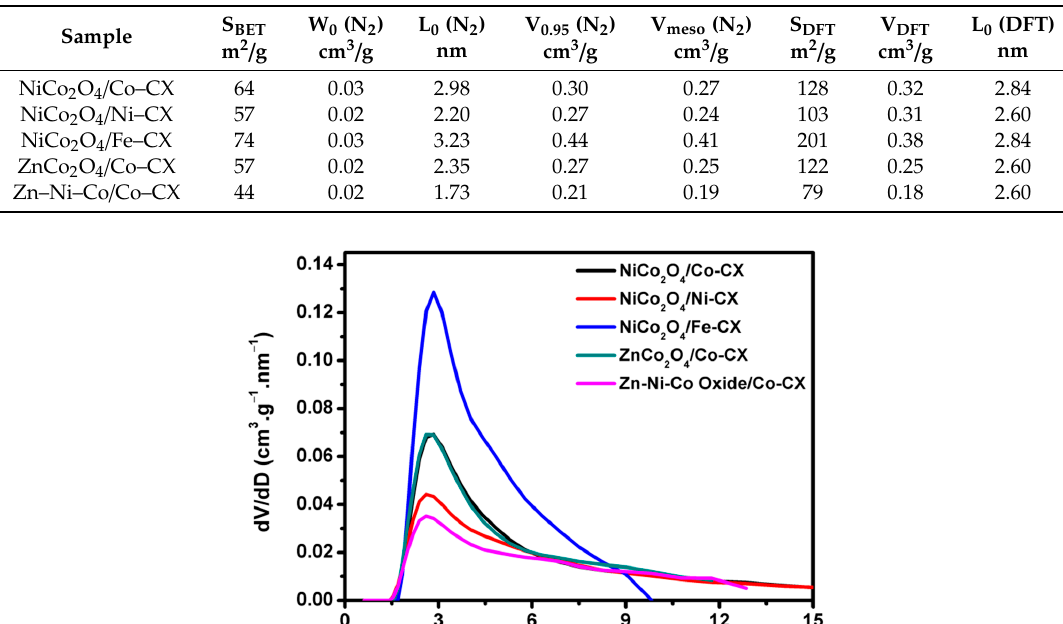
Figure 1. Pore size distribution from QSDFT analysis for the adsorption part of N 2 isotherms.